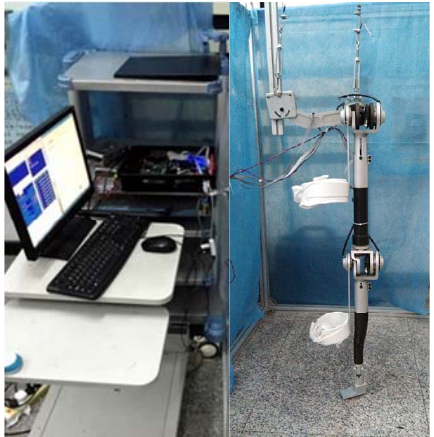
Figure 10. Exoskeleton robotics system. The whole control system consists of the embedded PC, programmable multi-axis controller (PMAC), Copley actuators, power supplement, and required auxiliary facilities integrated into the control